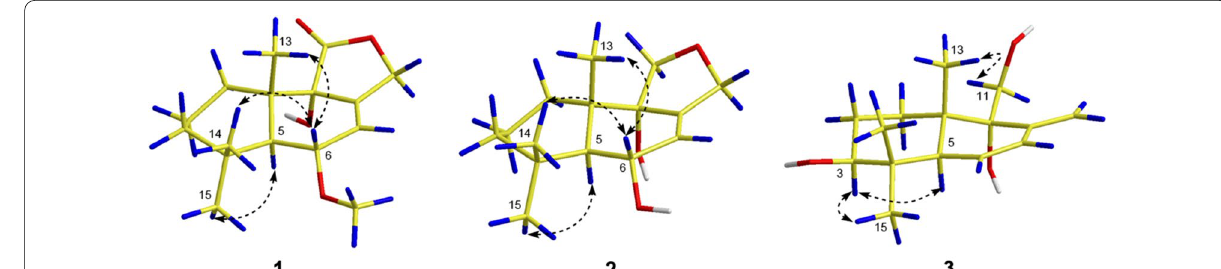
Fig. 3 Key NOESY correlations (dashed black arrows) of compounds 1 – 3